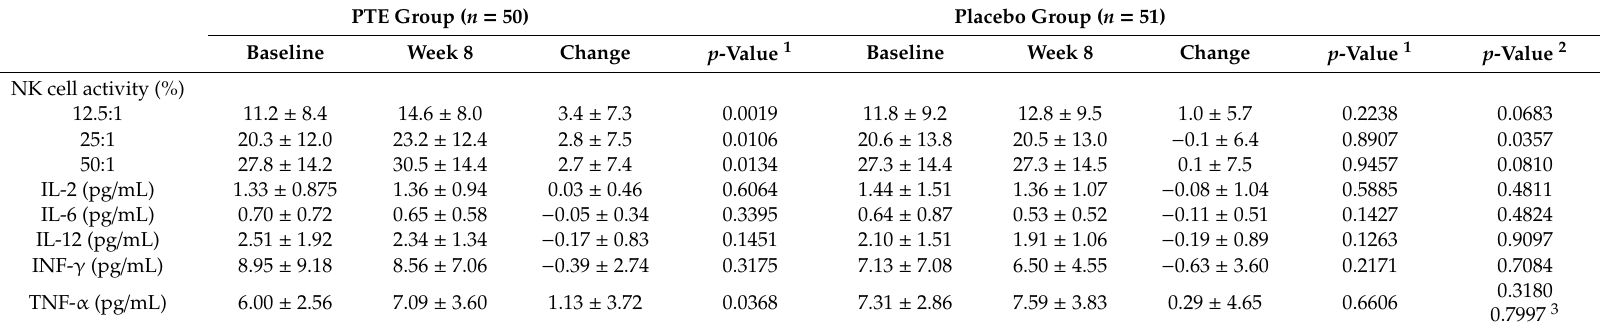
Table 5. NK cell activity and cytokine cluster analysis obtained prior to and after treatment in the two